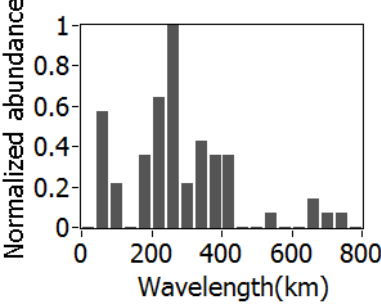
Figure 12. Normalized histogram (bin size: 40km) of the estimated wavelengths, projected on the orbiter-lander connecting line.